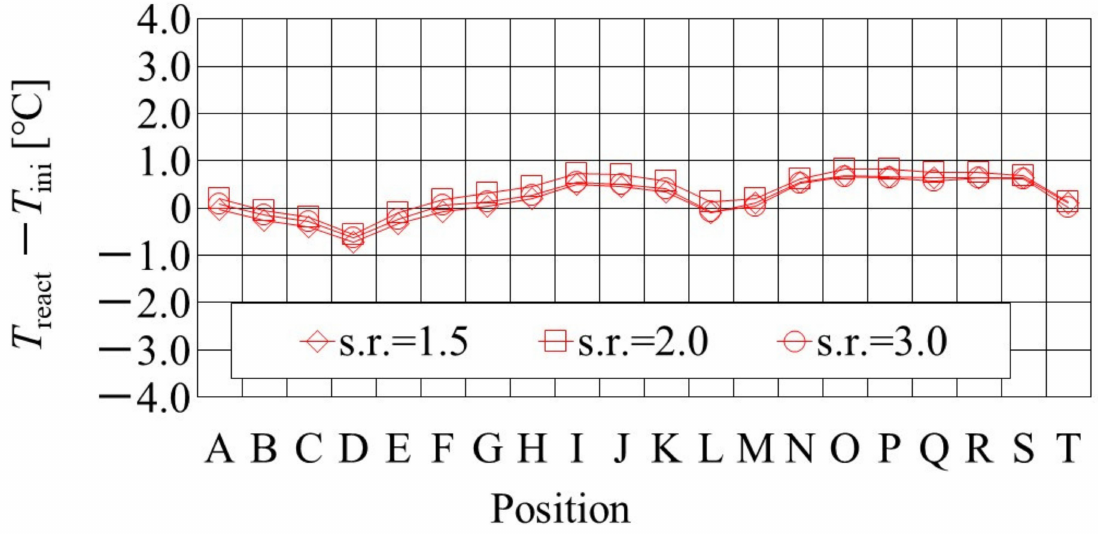
Figure 5. Effect of stoichiometric ratio of supply gas on distribution of temperature, difference between temperature at reaction surface and initial operation temperature, at the initial operation temperature = 80 ◦ C and A 80% RH and C 80%